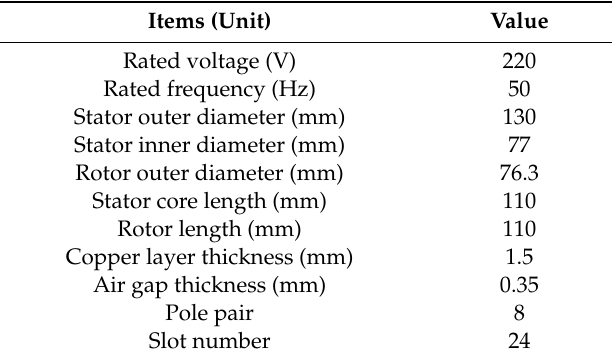
Table 1. Main parameters of the N-TWSRIM.